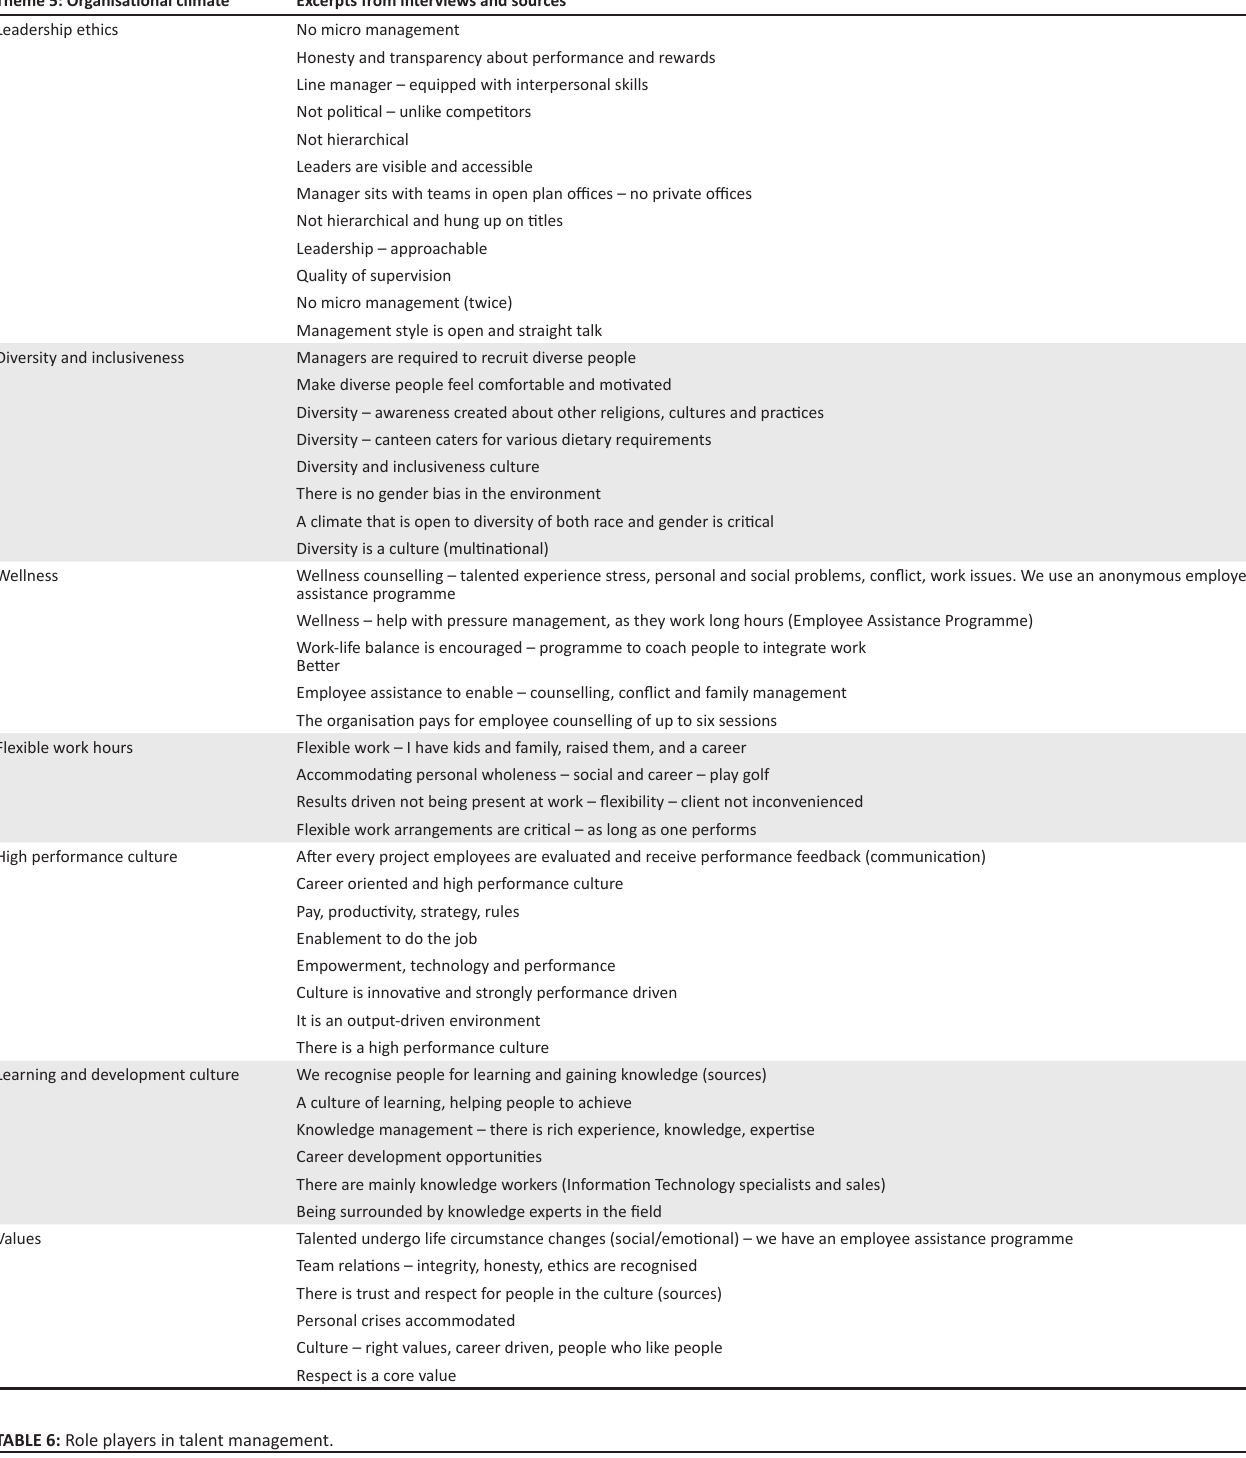
TABLE 5 (Continues...): Organisational climate and culture.